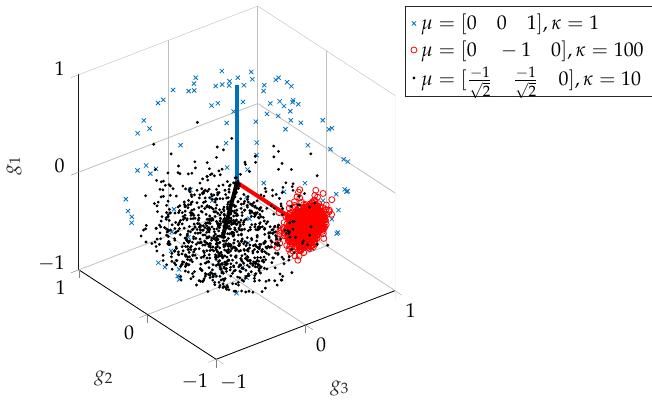
Figure 5. Three sets of mixes, drawn from the mix-space. This shows the effect of varying the concentration parameter κ , that a larger value results in less diversity.